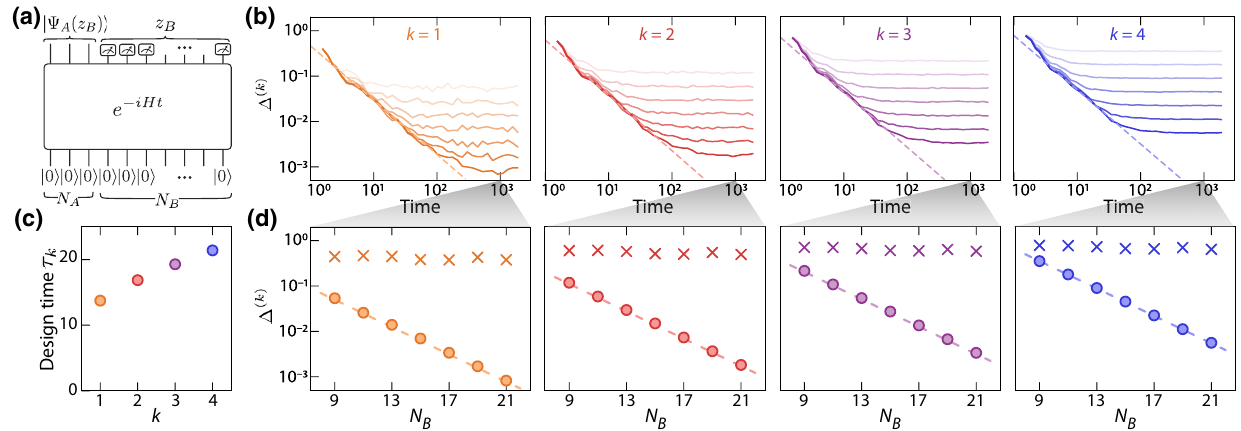
FIG. 3. Emergent quantum state designs from chaotic time evolution. (a) Quenched dynamics under a time-independent Hamiltonian H starting from an initial product state, | 0 (cid:2) ⊗ N , for a N -qubit system. The system is partitioned into two subsystems, A and B , with sizes N A and N B , respectively. At time t , a projective measurement in the local z basis is performed on subsystem B , resulting in a specific outcome z B of length N B . (b) The trace distances (cid:10) ( k ) between the k th moments of the Haar ensemble and projected ensembles for an N A = 3 subsystem as a function of the evolution time for various total system sizes N = 12, 14, . . . 24 (darker colors for increasing N ). The dashed lines are a phenomenological power-law fit, yielding a scaling of (cid:10) ( k ) ∼ t − 1.2 . (c) The design time τ k defined by the evolution time to achieve a trace distance of (cid:10) ( k ) = 0.02. We find that longer time evolution is required to form a higher approximate k -design. (d) Late-time trace distances at t ≈ 10 3 . For a mixed-field chaotic Hamiltonian (circles), the late-time trace distances exhibit an exponential scaling with N B while they remain nearly constant for an integrable nonergodic Hamiltonian (crosses; time traces not between the k th moments of the Haar ensemble and a finite set of 2 N B states shown). The dashed lines represent the trace distances (cid:10) ( k ) em